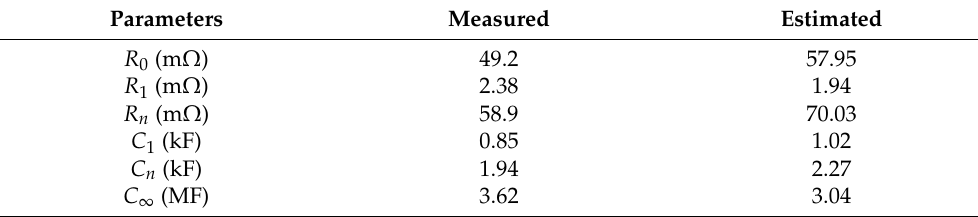
Table 11. Results of Case 4.